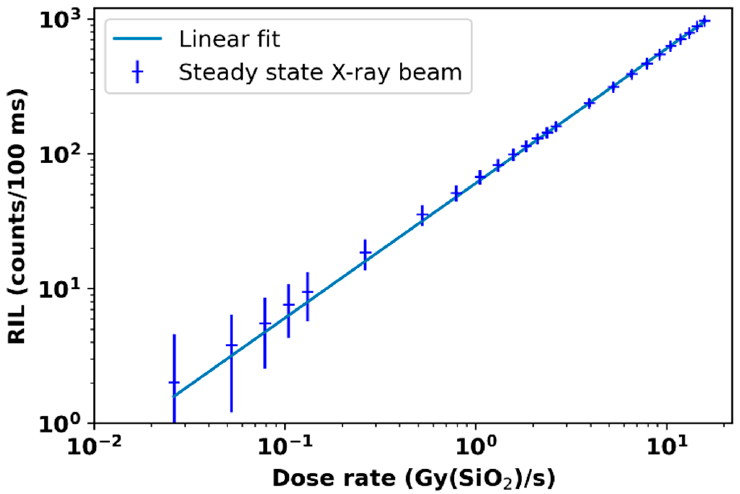
Figure 5. RIL dose rate dependence of the nitrogen-doped optical fiber performed with LabHX 40 keV X-ray machine.